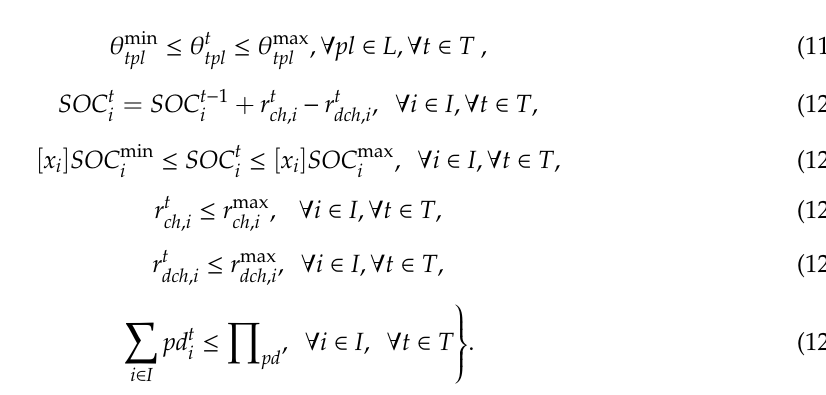
Table 4. Load shed of the IEEE 30-bus power system under di ff erent k ’s.